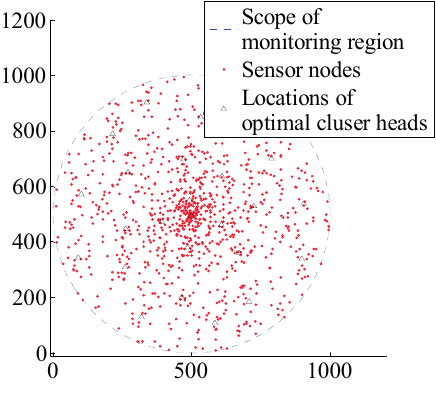
Figure 3. Distribution of optimal cluster heads when c = 25, N =